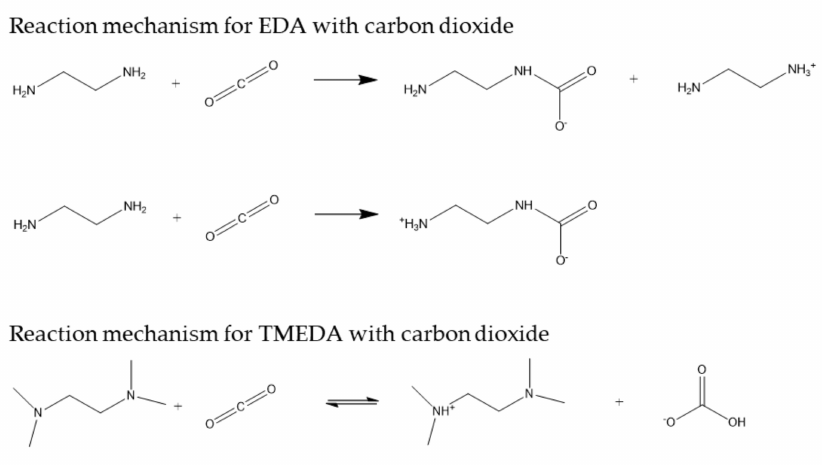
Figure 7. Reaction mechanisms for EDA- and TMEDA-based solvents for carbon dioxide chemical